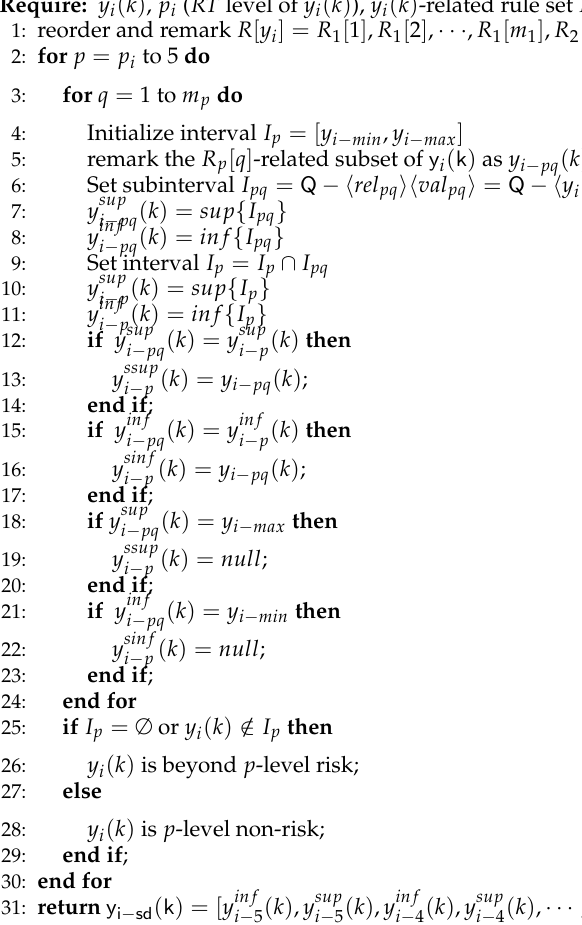
Algorithm 2 Critical state estimation